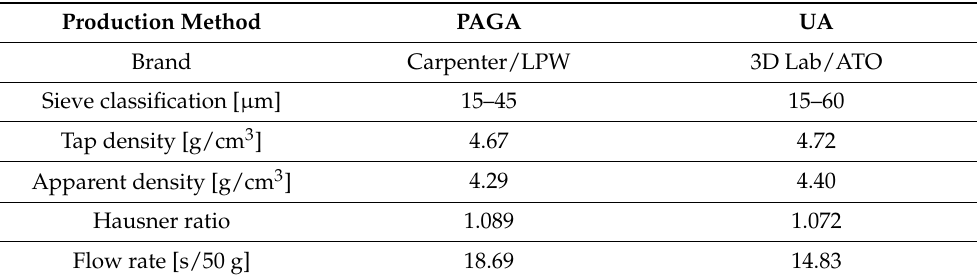
Table 3. Physical properties of the powder